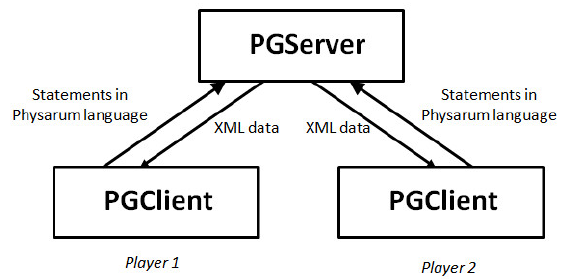
Figure 7: A general structure of the Physarum game simulator